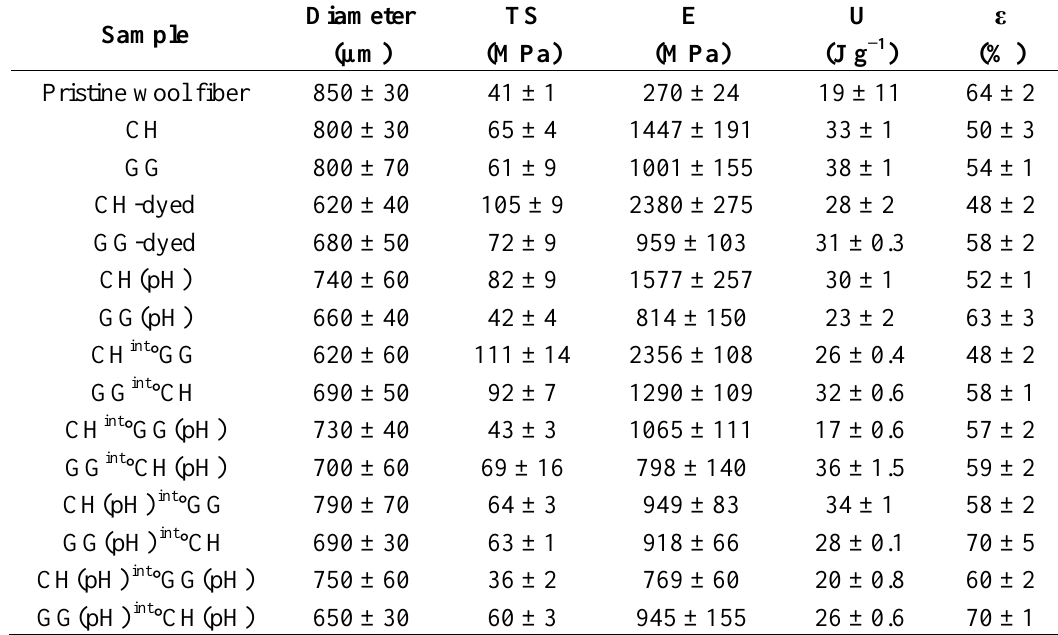
Table 2. Mechanical properties of dyed single-treated fiber (unless stated otherwise), pH adjusted single-treated fiber and dyed with pH adjusted polyelectrolyte complex (PEC)-treated fibers. CH-fibers and CH solutions were dyed with blue food color; and GG-fibers and GG solutions were dyed with yellow food color. Single-treated fibers immersed in CH and GG solution for 20 min and 5 min, respectively. For PEC-treated fibers, CHsingle-treated fiber immersed in GG solution for 20 min (CH int °GG) and GG single-treated fiber immersed in CH solution for 5 min (GG int °CH). Tensile strength (TS), Young’s modulus (E), work of extension (U) and extension ( ) of treated fibers are